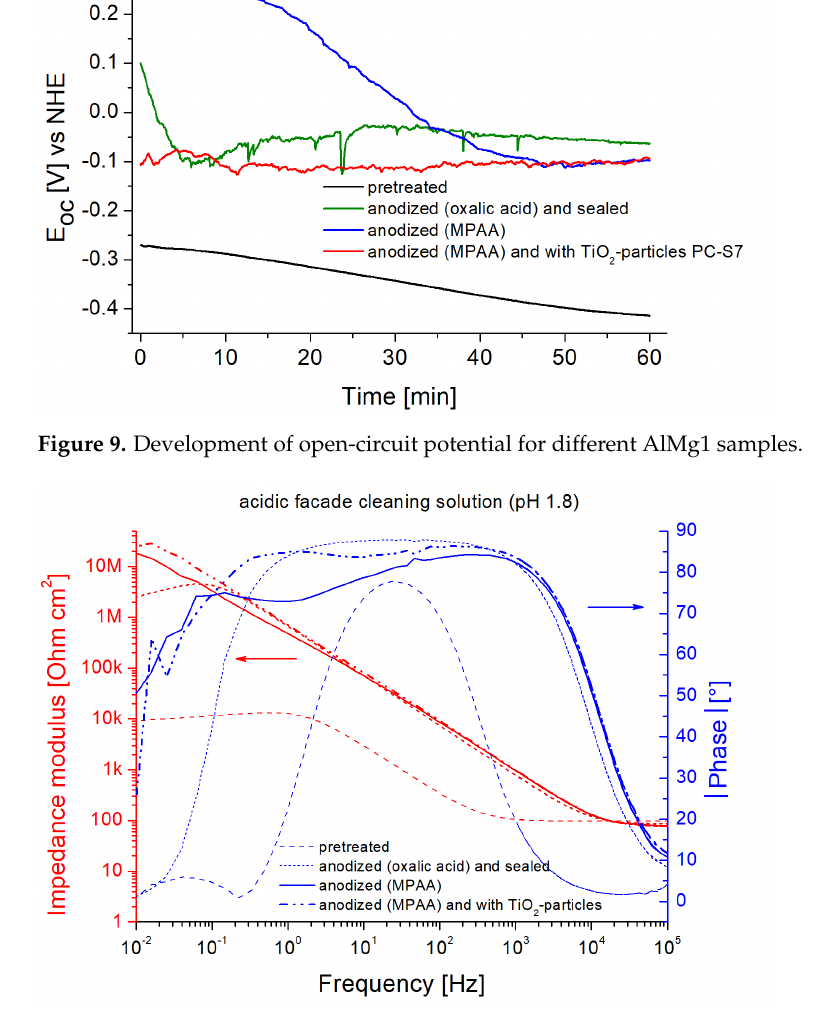
Figure 10. Bode plot of impedance spectra of AlMg1 treated under different